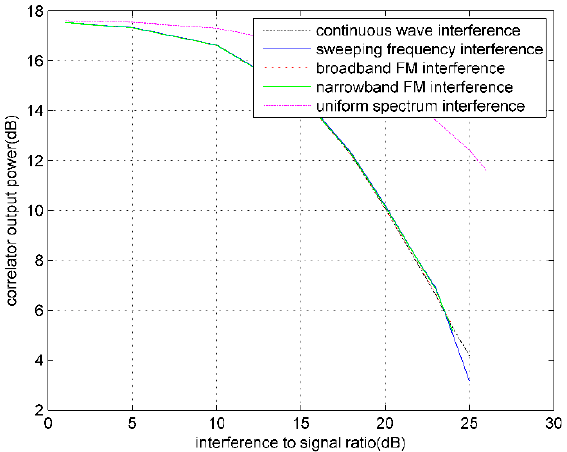
Figure 4. Influences of different RFIs on COP .